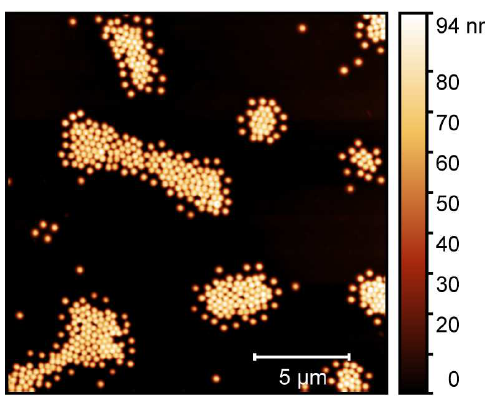
Figure 3. Atomic force microscopy image of adsorbed copolymer microgel particles (P(NIPAM- co - NIPMAM)) cast from water. The measurements have been performed in the completely dried state on a PEI-coated silicon